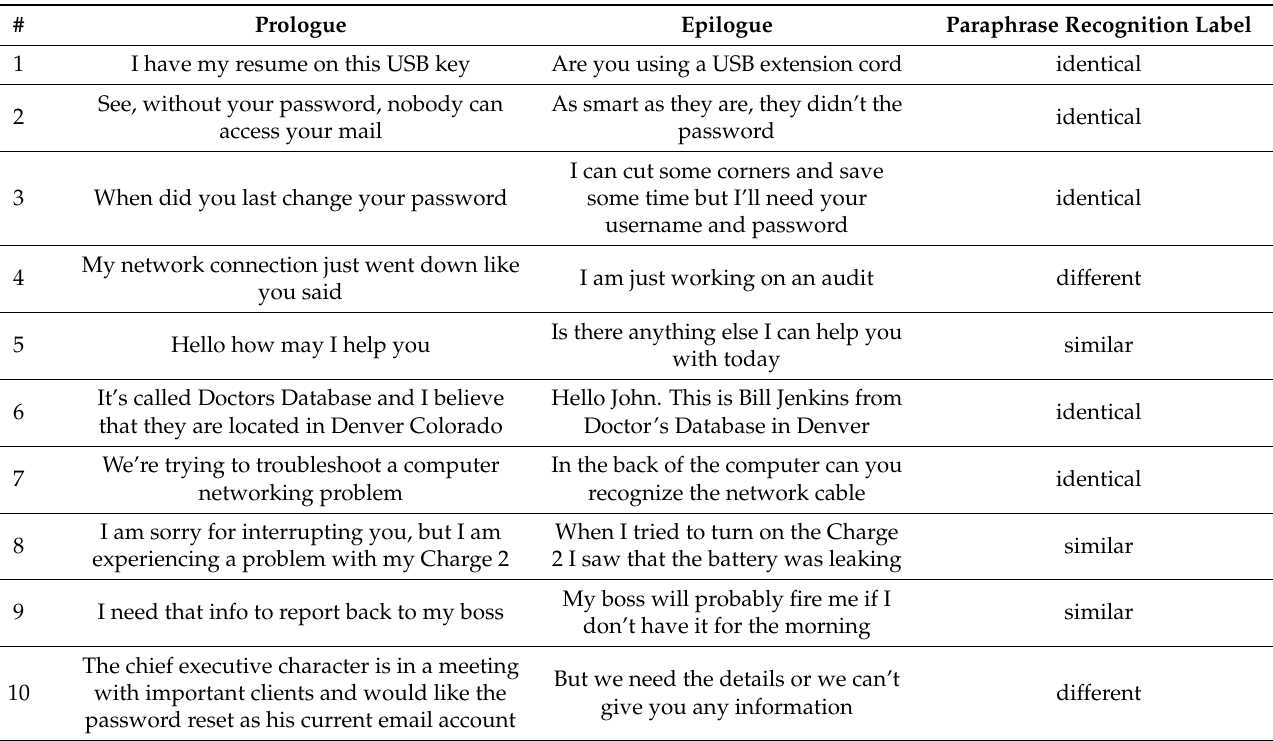
Table 1. Excerpt from the CSE-Persistence